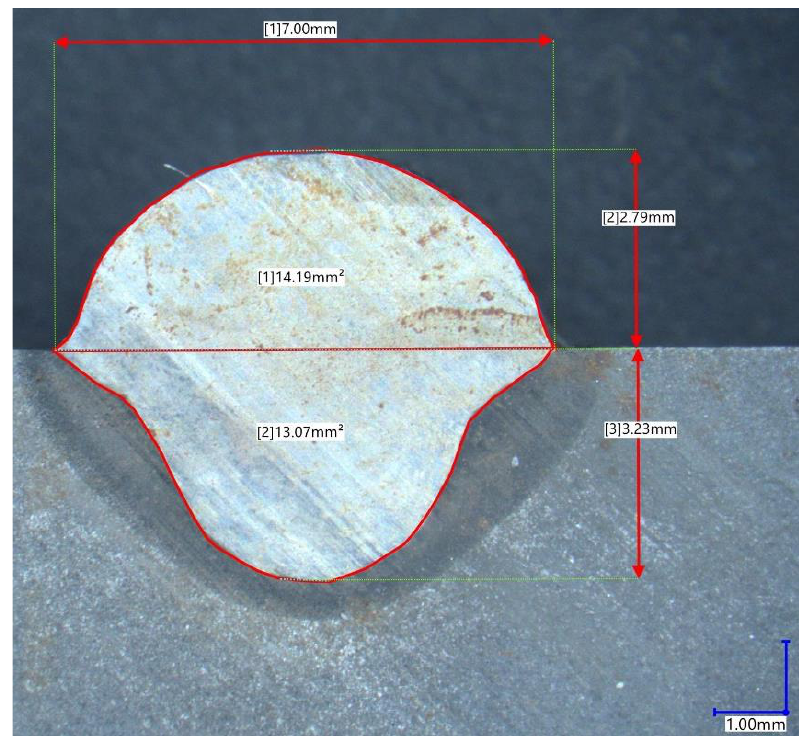
Figure 5. A microscopic view on the cross-sectional geometry of the weld bead.